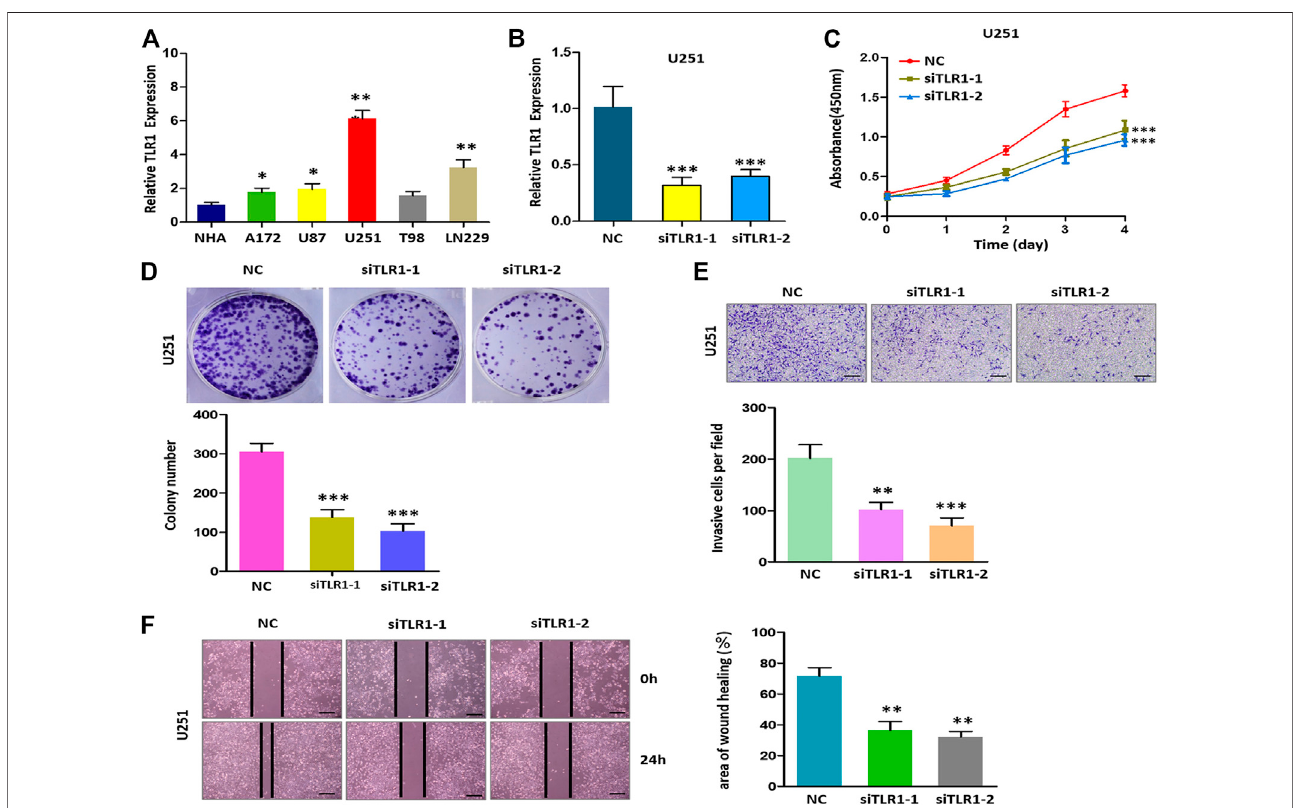
FIGURE 9 | Decreased the expression of TLR1 inhibits proliferation, invasion, and migration of glioma cells in vitro . (A) Relative expression of TLR1 in 6 cell lines. (B) qRT-PCR to detect the relative silencing levels of TLR1 in the U251 cell line. (C) The CCK-8 assay was applied to detect the ef fi ciency of TLR1 knockdown on the proliferation of the U251 cell line. (D) Images of the colony formation assay after knockdown of TLR1 in U251 cell line. (E) Images of the transwell assay results after knockdown of TLR1 in U251 cell line. (F) Representational images of the wound healing assay.